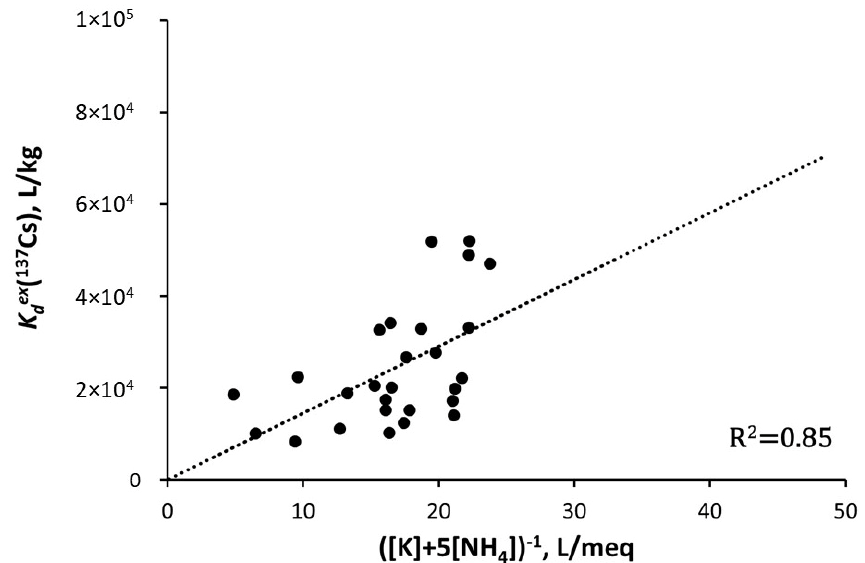
Figure 2. Correlation between 𝐾 (cid:3031)(cid:3032)(cid:3051) and inverse effective concentration of major Cs competitive cations ((cid:4670)𝐾 (cid:2878) (cid:4671) + 5(cid:4670)𝑁𝐻 (cid:2872)(cid:2878) (cid:4671)) (cid:2879)(cid:2869) for Funasawa pond in close vicinity of FDNPP in 2015–2019 [79].